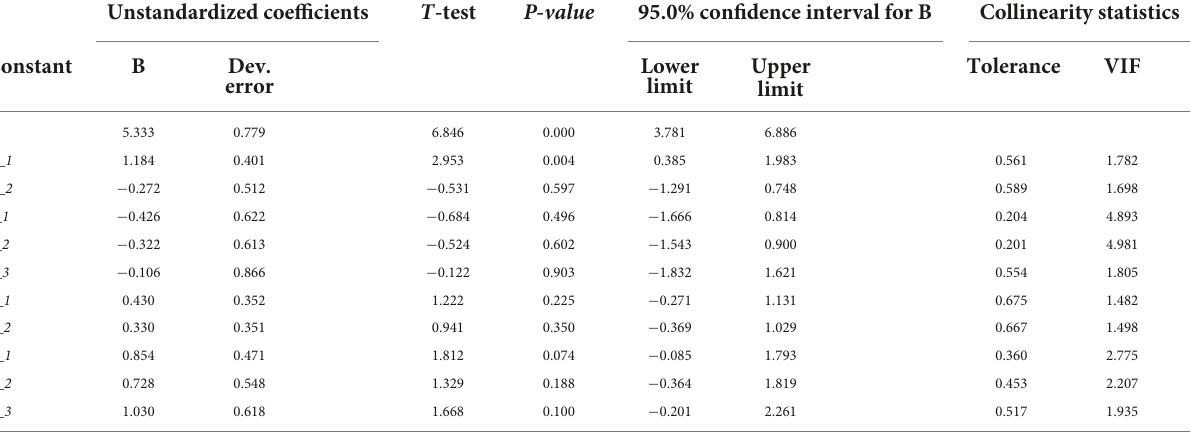
TABLE 7 Coefficients, significance, and collinearity of the parameters of the academic results prediction equation.